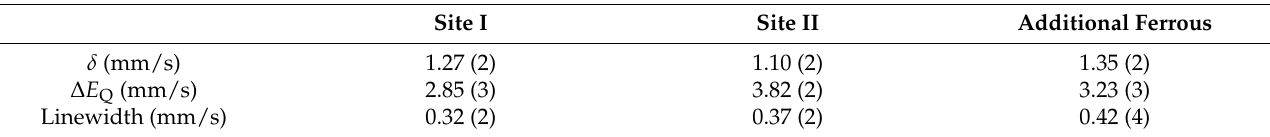
Table 3. Mössbauer parameters of high-spin ferrous species detected in loading experiments using DgrDps WT and ∆ N. Contribution of each species in each spectrum after deconvolution is given in percentage and occupancy values. Values in brackets are uncertainties of the last significant